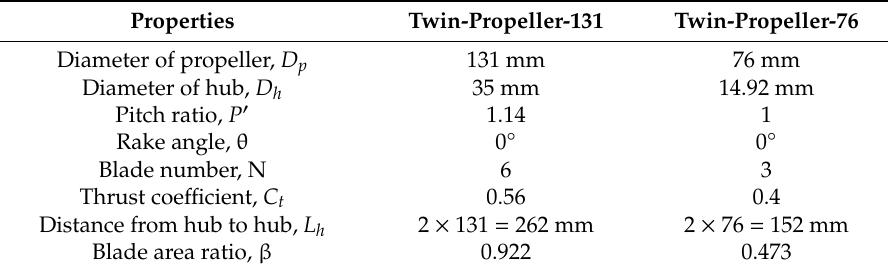
Table 1. Propeller